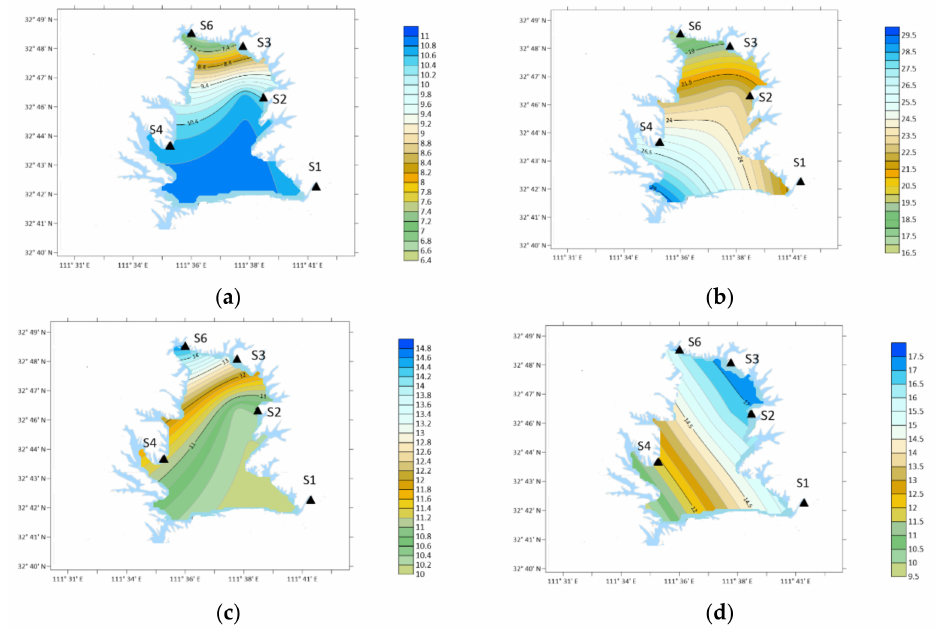
Figure 9. Spatial variation of BA concentration. ( a ) Winter; ( b ) spring; ( c ) summer; ( d )